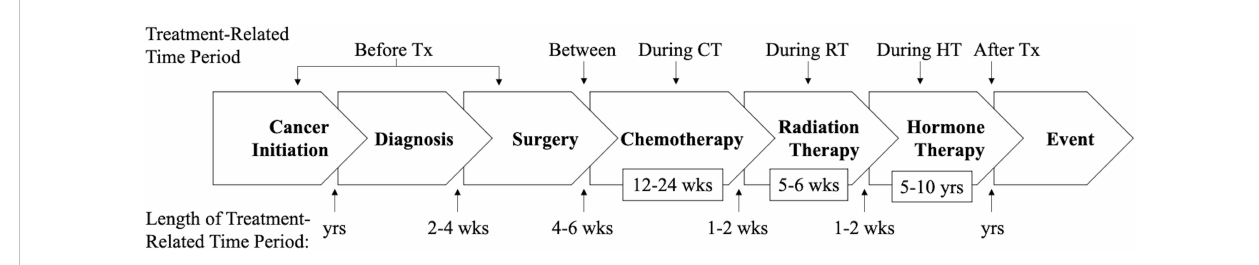
FIGURE 2 Diagram of the suggested timing of physical activity assessments under a hypothetical cancer treatment protocol. PA, physical activity; Tx, treatment; CT, chemotherapy; RT, radiotherapy; HT, hormone therapy; yrs, years; wks,